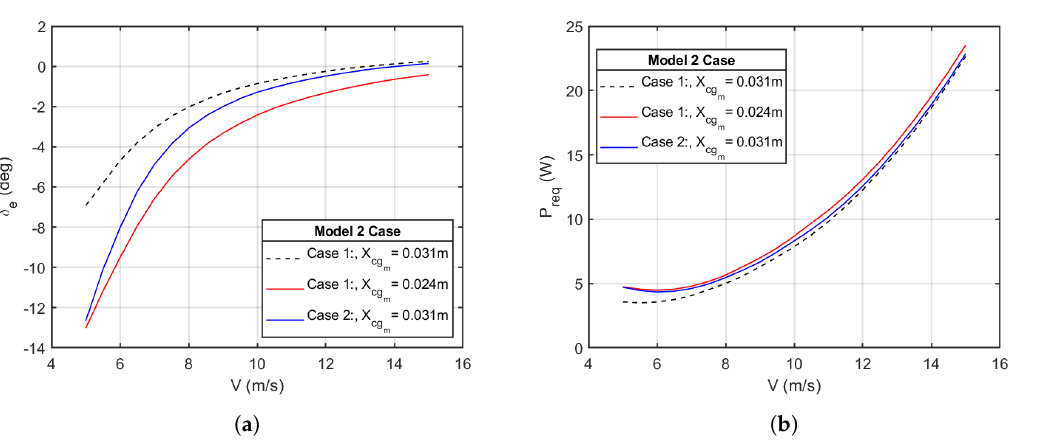
Figure 9. Model 2 trim in steady level powered flight for a range of airspeed. ( a ) Elevator deflection vs. airspeed. ( b ) Power required vs. airspeed. Table 8. Trimmed steady cruise elevator deflection and power required for Model 2